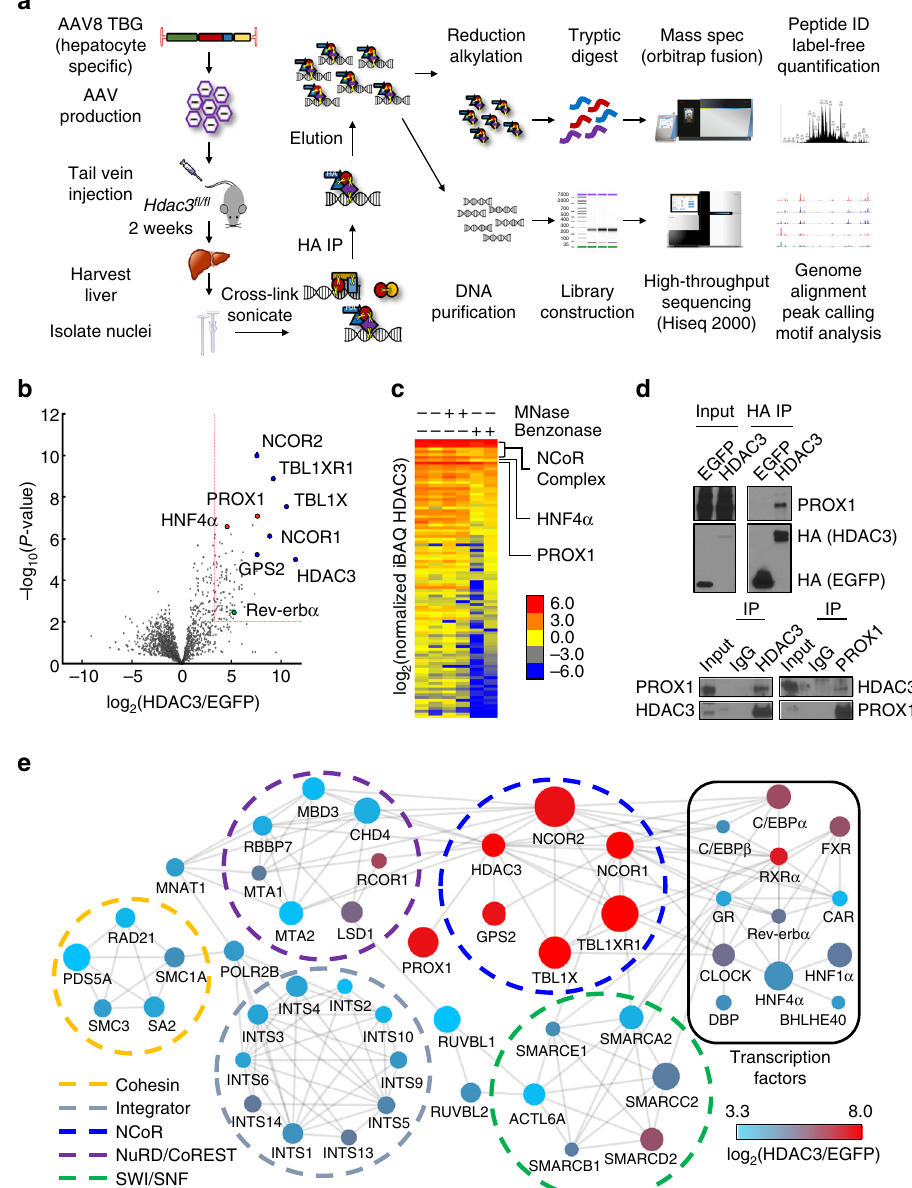
Fig. 1 NEAT ChIP-MS reveals the HDAC3 liver nuclear interactome. a Schematic illustration of the NEAT ChIP-MS protocol. HA-tagged HDAC3 or EGFP was expressed with or without Cre in Hdac3 fl / fl mice speci fi cally in hepatocytes via adeno-associated virus (AAV8 TBG). After isolation of nuclei and cross- linking with formaldehyde, HDAC3 or EGFP control were captured by anti-HA immunoprecipitation. Protein complexes and associated DNA sequences were analyzed by mass spectrometry or high-throughput sequencing, respectively. b Volcano plot of mass spectrometry analysis of HDAC3 interacting proteins (HDAC3 n = 11, EGFP n = 13). The x axis indicates log 2 ratio of normalized intensity (iBAQ) of proteins discovered in HDAC3 to EGFP control. Red box indicates fold-change (10-fold) and P -value (0.01) cutoffs for interactors. Core NCoR complex components ( blue ), selected high scoring interactors ( red ), and Rev-erb α ( green ) are indicated. c Heatmap of normalized intensity (iBAQ) of HDAC3 interactors from b in the presence or absence of micrococcal nuclease (MNase) or Benzonase nuclease. Each lane represents an independent experiment. d Co-IP experiments con fi rming interaction of HDAC3 with PROX1 from liver expressing tagged HDAC3 ( top ) or endogenous IPs ( bottom ). e Protein – protein interaction network analysis. Circle color represents enrichment over control and the size of the circle represents − log 10 ( P -value). Nodes displayed met eightfold enrichment cutoff after Benzonase treatment and lines indicate validated interactions (STRING, active interaction sources include experiments and databases, minimum interaction score 0.6). Interactors are grouped by known type and circles indicate known functional